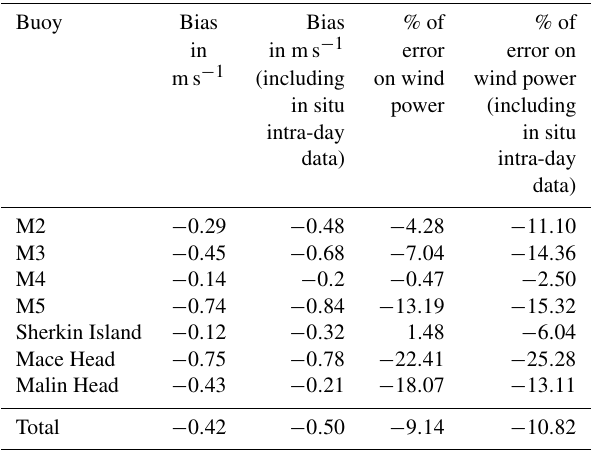
Table 8. Increase in the bias and the error on the wind power when intra-diurnal data of in situ measurements are taken into account, compared with the same results obtained for the match-up compar- ison. Buoy